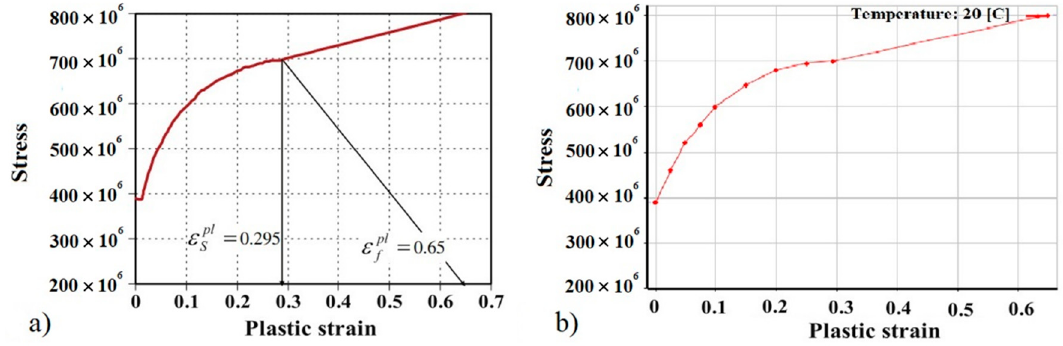
Figure 7. True stress–strain curve used to simulate S355 material: ( a ) Al-Thairy et al. [21], ( b ) used in finite element code.